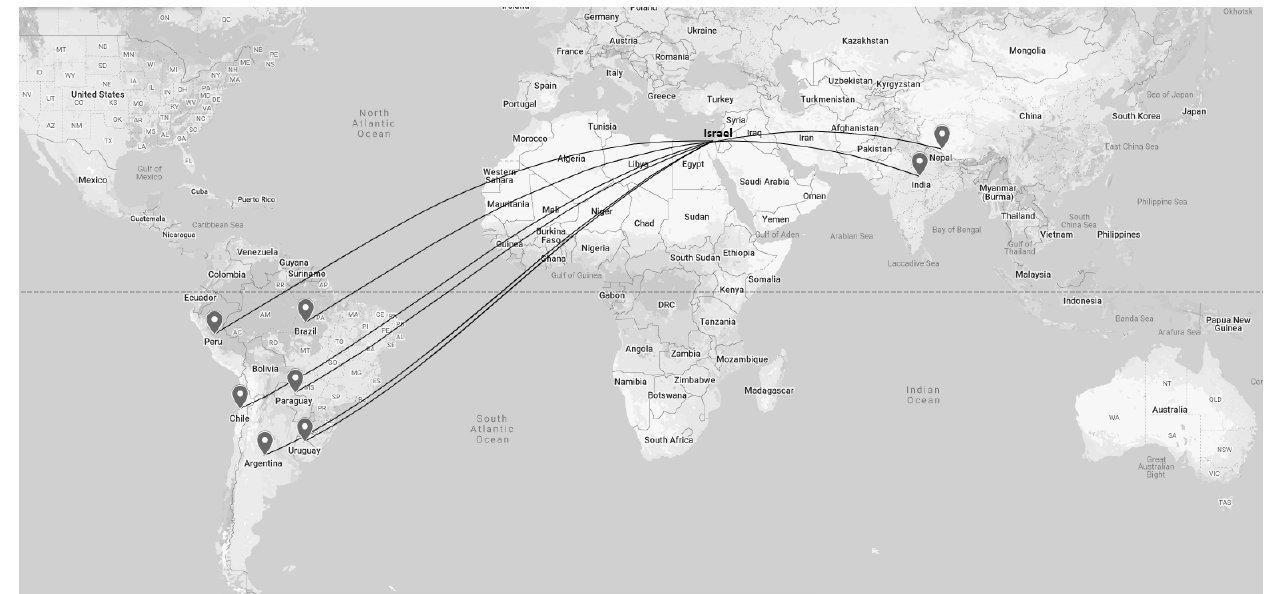
Figure A1. The participants’ locations at the time of the study.